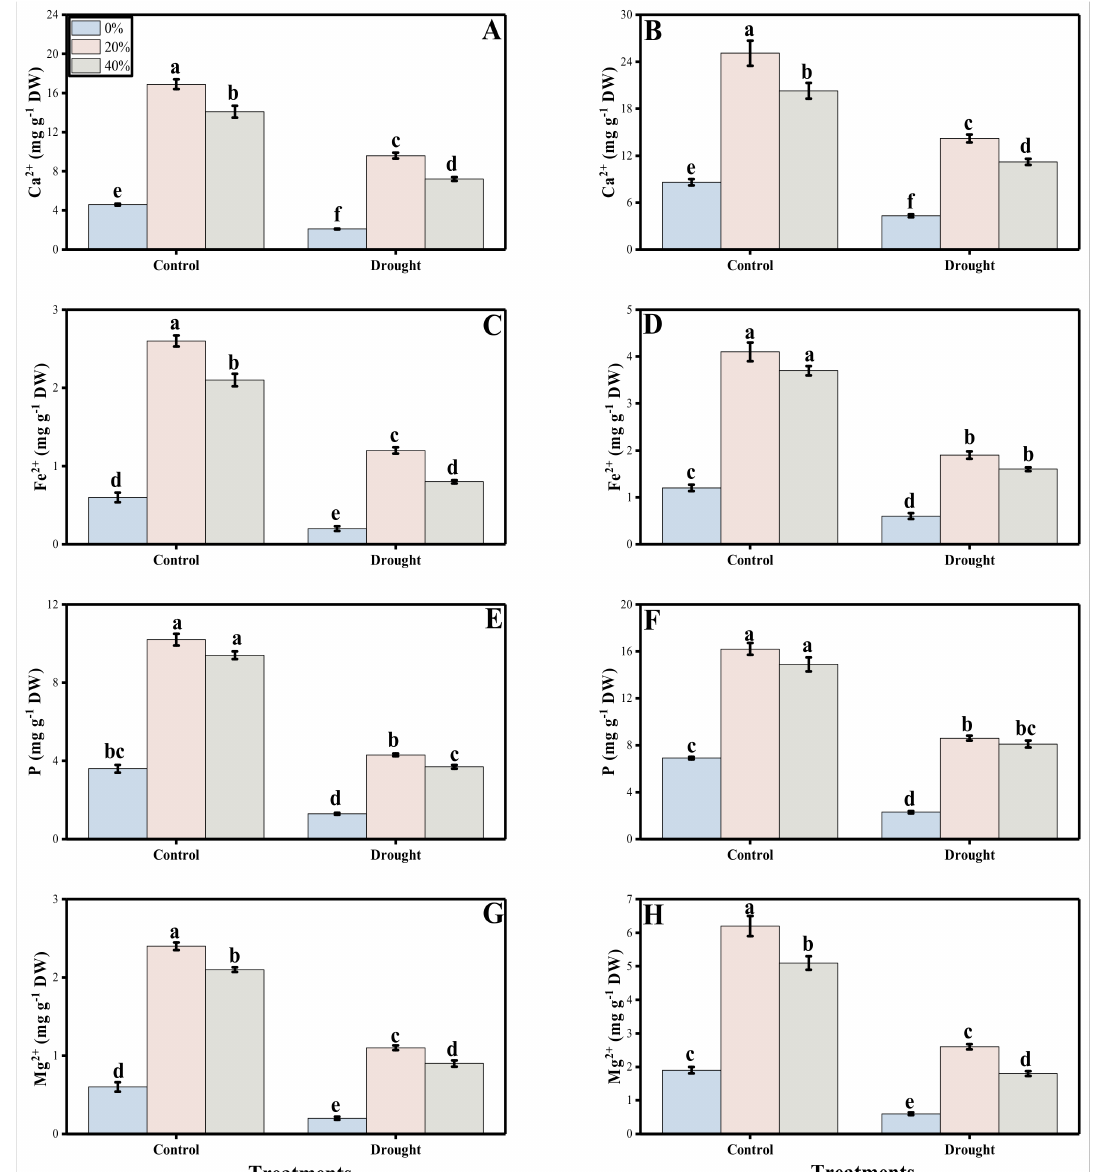
Figure 8. Effect of seed priming with Plantago ovata leaf extract on magnesium contents in the roots ( A ), magnesium contents in the shoots ( B ), phosphorus contents in the roots ( C ), phosphorus contents in the shoots ( D ), iron contents in the roots ( E ), iron contents in the shoots ( F ), calcium contents in the roots ( G ) and calcium contents in the leaves ( H ) under water stressed and non-stressed environments in maize cultivar Cimmyt − Pak. Means sharing similar letter(s) within a column for each parameter do not differ significantly at p < 0.05. Data in the figures are means of three repeats ( n = 3) of just one harvest of Zea mays plants ± standard deviation (SD). Different lowercase letters on the error bars indicate significant difference between the treatments. Different treatments ( P. ovata extract) used in this study are as follows: 0% (0% P. ovata extract), 20% (20% P. ovata extract) and 40% (40% P. ovata